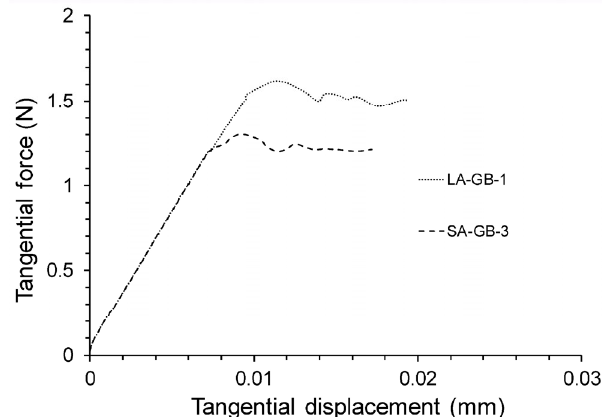
Fig. 14 Representative results of tangential force against tangential displacement at the interfaces of the glass balls and a comparison between the small-size and large-size devices.